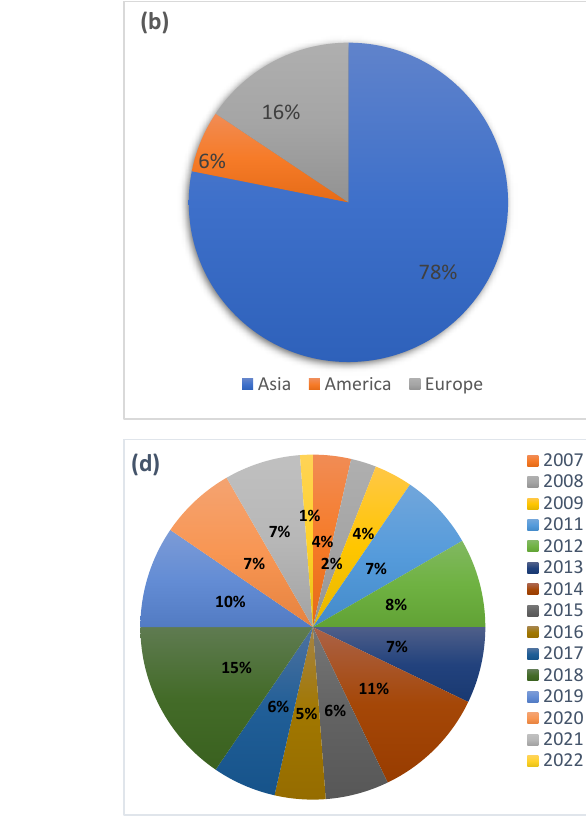
Figure 1. The percentages of studies conducted in the field of antibiotics in ( a ) seas, ( b ) rivers, and ( c ) lakes on different continents, and ( d ) the percentages of studies conducted during different years.